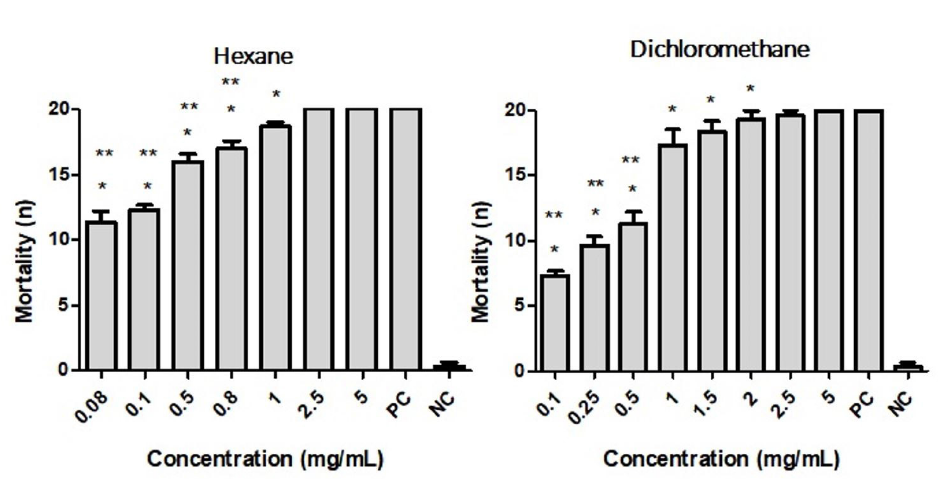
Figure 7. Adulticidal activity – body contact of different concentrations of fractions of Helicteres velutina on Aedes aegypti mosquito after 48 hours. PC = Positive Control, NC = Negative Control (*) Results significantly different from negative control. (**) Results significantly different from positive control.